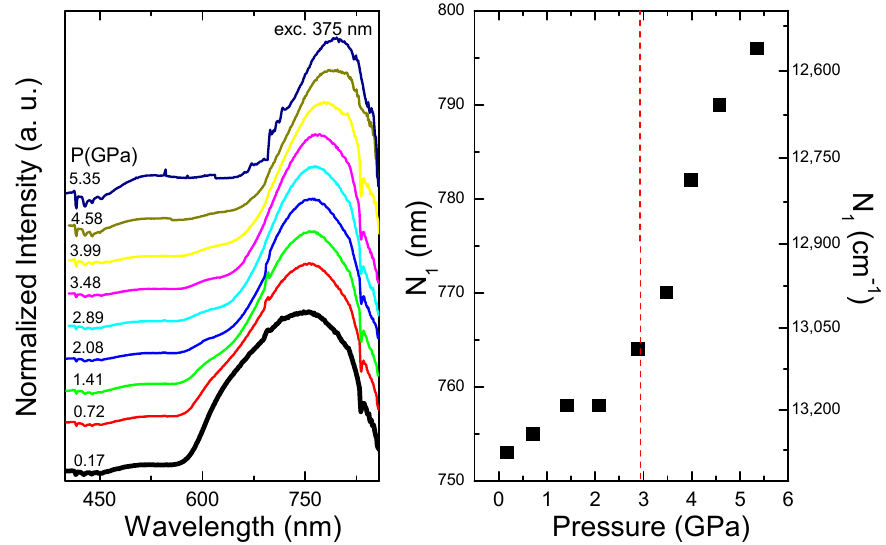
Figure 10. Pressure dependence of luminescence spectra of [(CuI) 2 (Quin)] compound obtained at ambient temperature under 375 nm laser excitation.